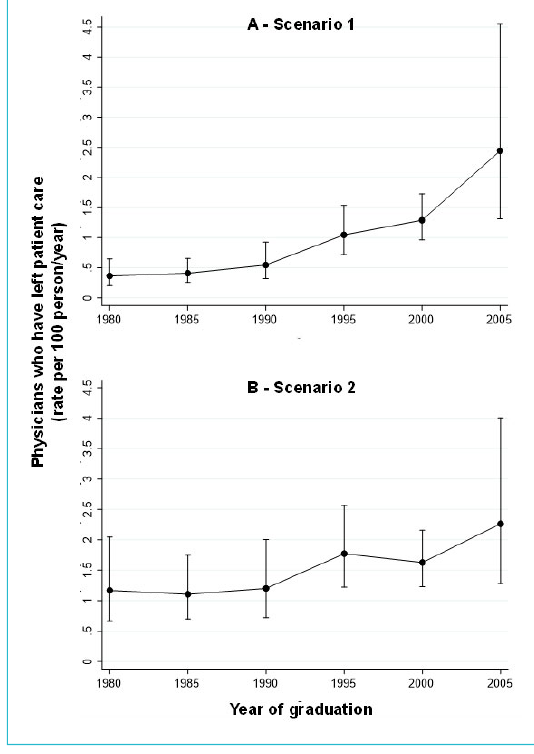
Figure 2: Rates of physicians leaving patient care by year of grad- uation and scenario.